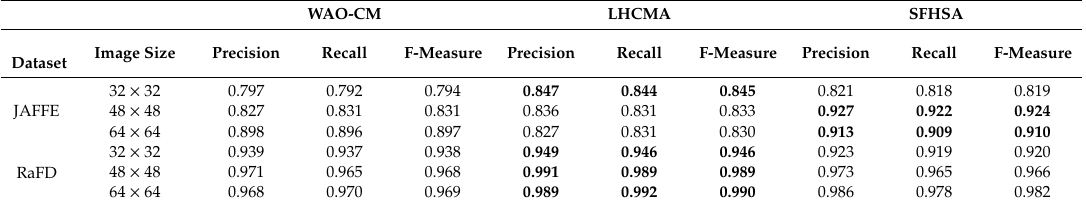
Table 10. Performance of SFHSA with respect to WAO-CM and LHCMA for Gabor-based features in terms of Precision, Recall and F-measure.